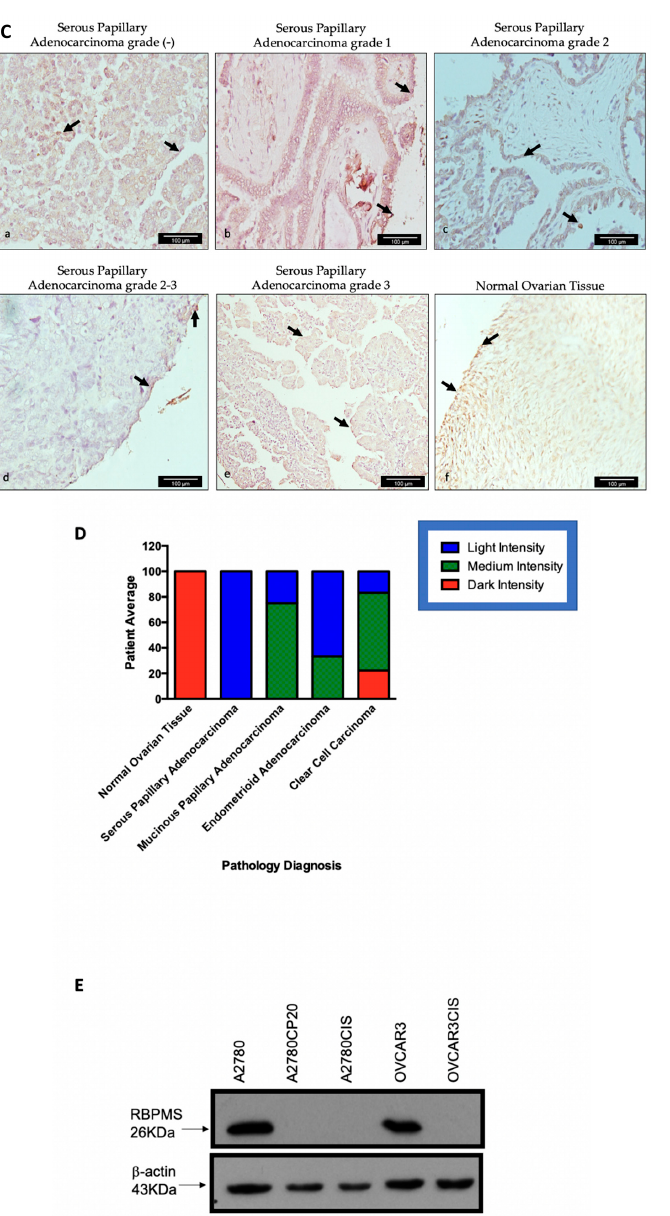
Figure 1. RBPMS protein levels are reduced in ovarian cancer tumor samples and correlate with poor prognosis: ( A ) Relative expression levels of RBPMS in ovarian cancer tumor tissues and normal ovarian tissues were analyzed using the GEPIA bioinformatic tool. * p < 0.05. The red box represents the cancer tissue samples, while the black box represents the normal tissue samples. ( B ) Survival plots of the ovarian cancer patients were generated using the Kaplan–Meier (KM) plotter. Overall survival (OS) and disease-free survival (DFS) of patients with ovarian cancer stratified by expression levels of RBPMS are shown based on RNA-Seq data (graphs generated automatically using GEPIA). ( C ) Representative images of IHC analysis of the tissue array. ( a ) Non-assigned grade (-) serous papillary adenocarcinoma. ( b ) grade 1 serous papillary adenocarcinoma. ( c ) grade 2 serous papillary adenocarcinoma. ( d ) Grade 2–3 serous papillary adenocarcinoma. ( e ) Grade 3 serous papillary adenocarcinoma. ( f ) normal ovarian tissue. Microscopy images were taken at 40 × magnification. ( D ) Relative RBPMS immunoreactivity staining in the different ovarian cancer types included in the tissue array. ( E ) Western blot of RBPMS protein levels in cisplatin-sensitive and cisplatin-resistant ovarian cancer cells. The whole Western blot image is shown in Supplementary Figure